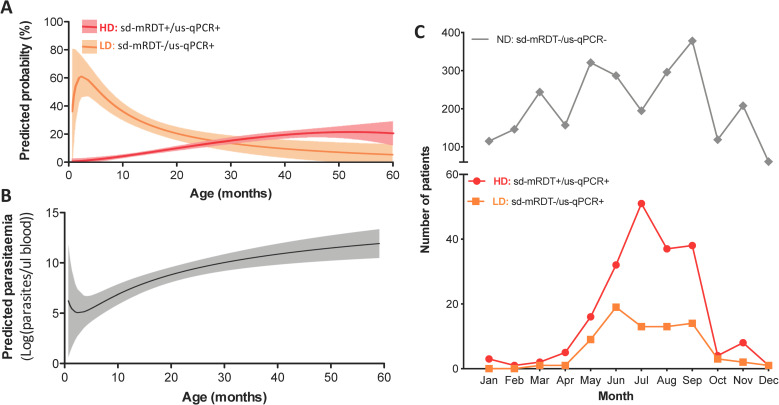
Temporal and age distribution of patients with LD, HD, and ND parasitemia.(A) Predicted probability of being assigned to the HD or LD group according to age (fitted fractional polynomial plot). Shaded regions are 95% CI; (B) Predicted probability of parasite density by age (fitted fractional polynomial plot); (C) Number of patients with HD and LD parasitemia identified for each month of the 2016 recruitment period. HD, high-density Pf infection, LD, low-density Pf infection; RDT, rapid diagnostic test; ND, no detectable Pf parasitemia; sd-mRDT, standard malaria RDT; us-qPCR, ultrasensitive quantitative polymerase chain reaction.